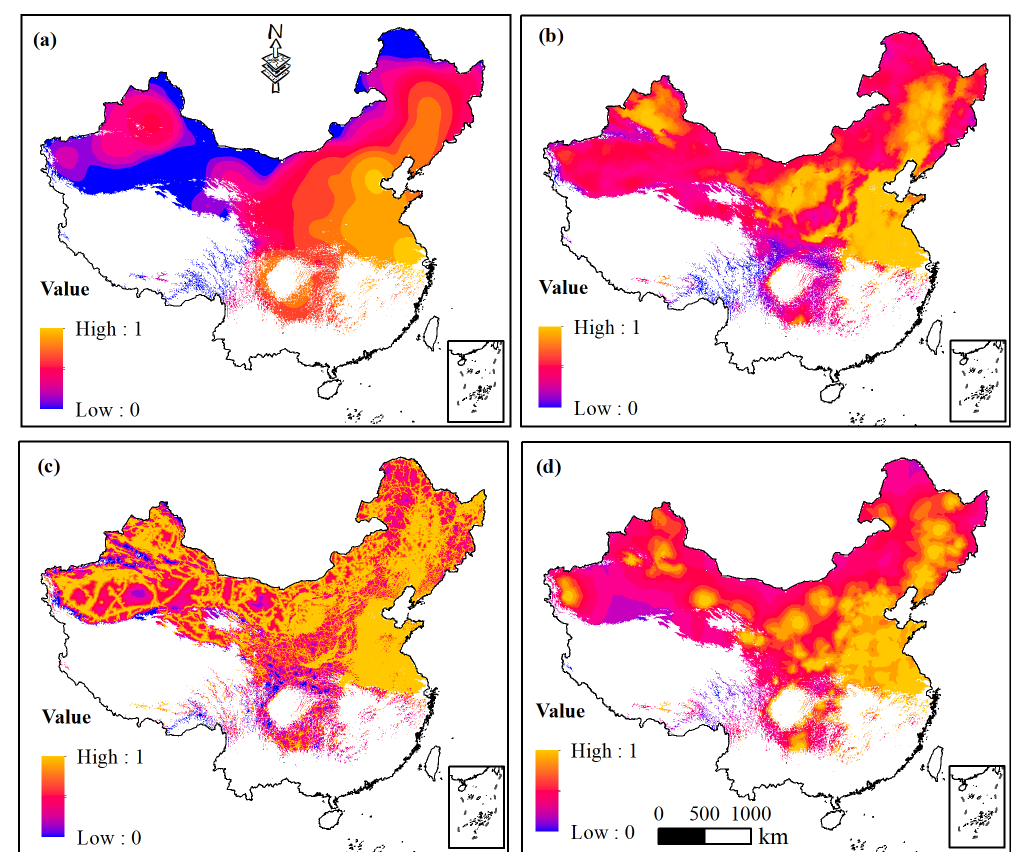
Figure 2. The spatial distribution of the socioeconomic condition indexes.